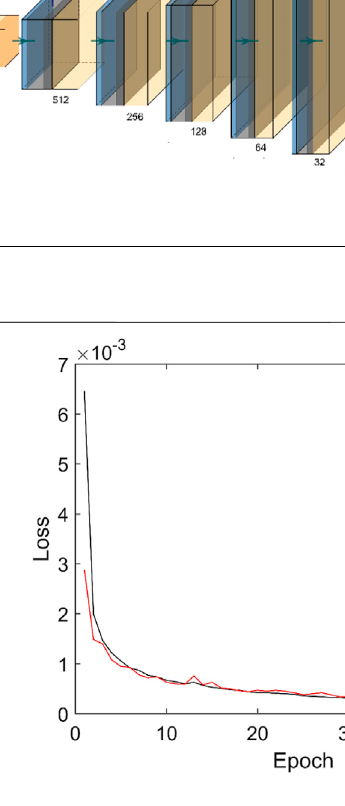
FIGURE 4 | Curve of loss function during training (black is training dataset; red is validation